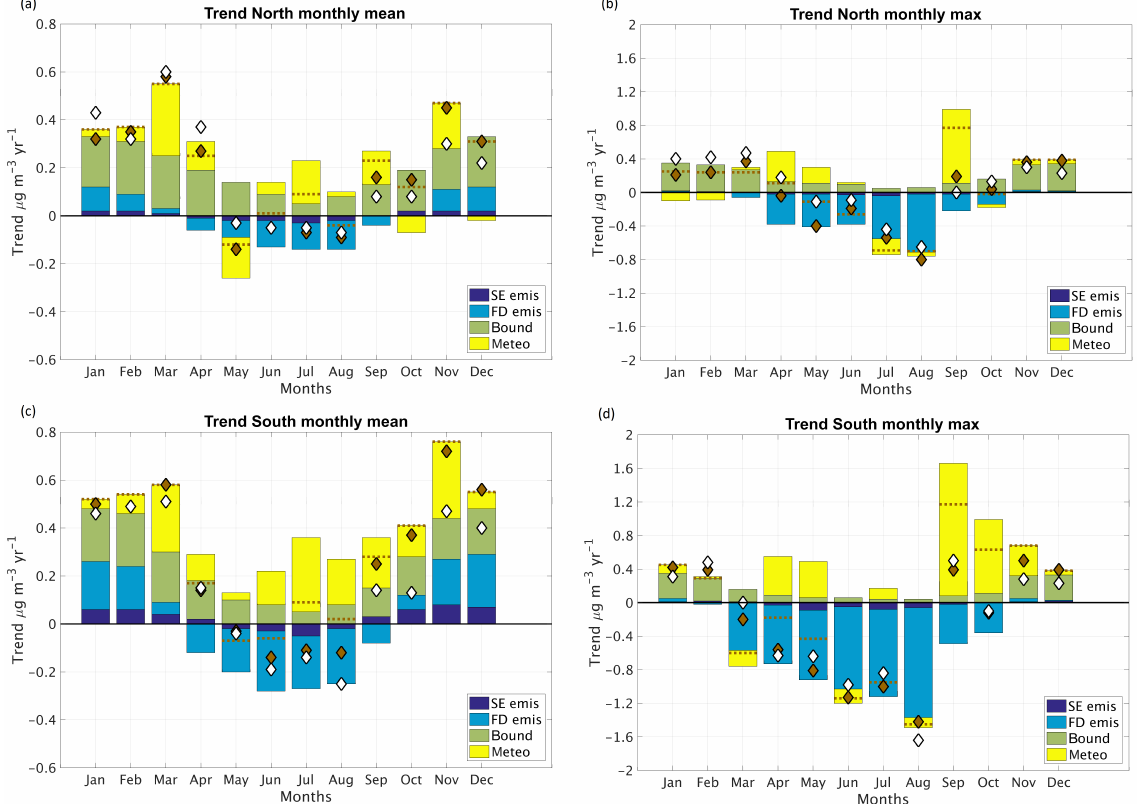
Figure 9. Linear trend over 1990–2013 in monthly mean (a, c) and monthly maximum 1h mean (b, d) near-surface ozone concentration for the north (a, b) and the south (c, d) Sweden regions (see Fig. 3). Reanalyzed (white diamond; LONGTERM reanalysis) and modeled first guess (MFG) near-surface ozone trend (brown diamond), and modeled contributions to the near-surface ozone trend due to change in emissions: anthropogenic Swedish (dark blue, SE emis) and full domain, non-Swedish (light blue, FD emis) emissions; trend in top and lateral boundaries of relevant species (dark yellow, bound) and variation in meteorology (light yellow, meteo). The sum of the modeled contributions is indicated by the dashed brown